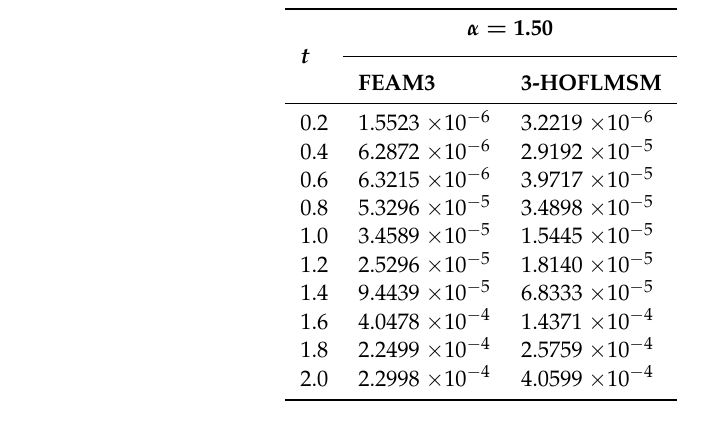
Table 11. Absolute error when α = 1.50 and N = 100 at each point, t using FEAM3 and 3-HOFLMSM in solving Example 5.